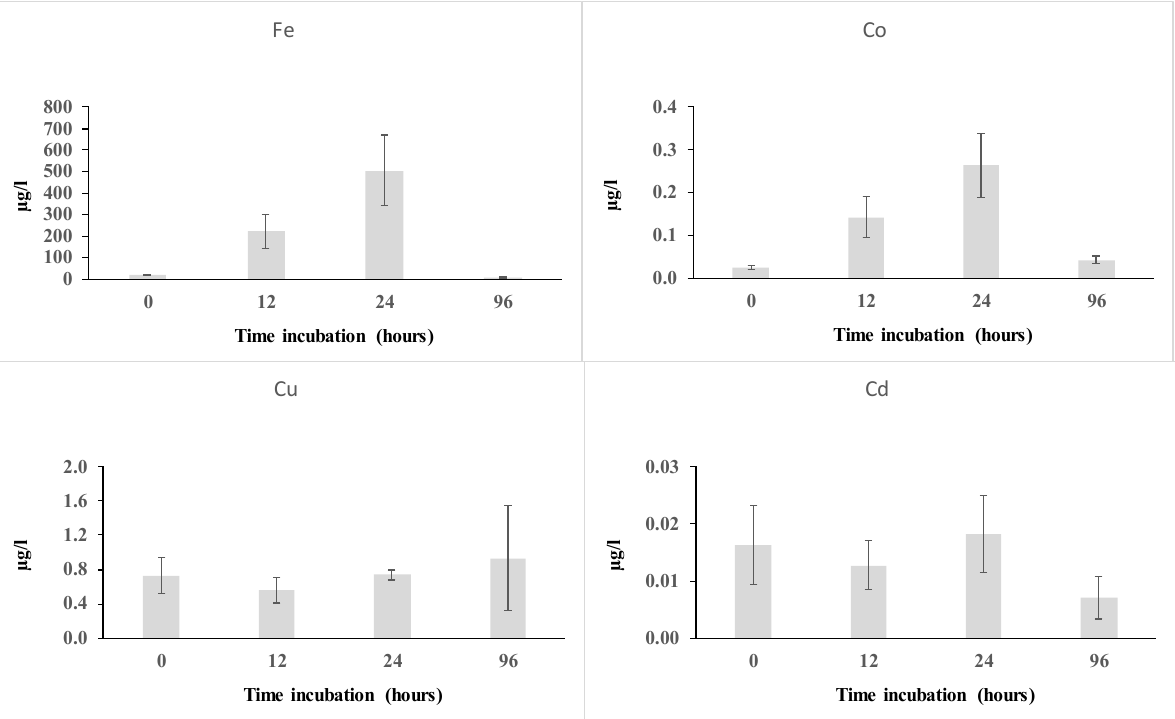
Figure 2. Concentration of trace metals during incubation experiment in mQ water.